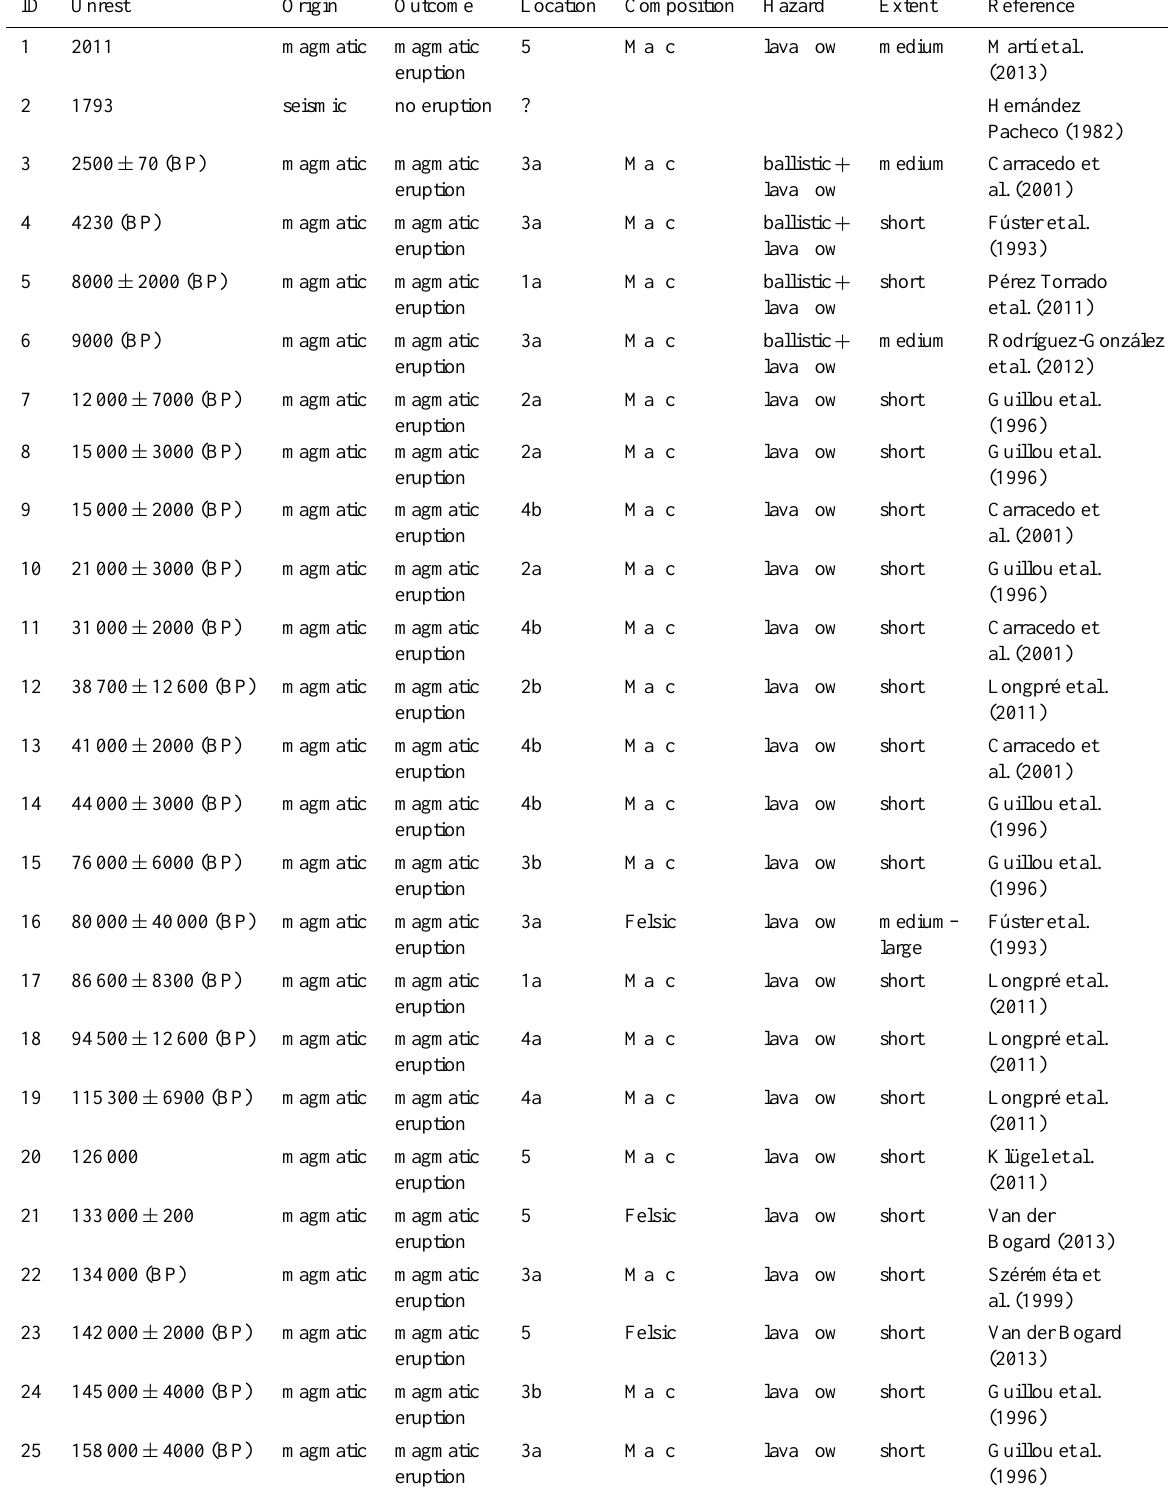
Table 1. The principal characteristics of the eruptions identified during the last constructive episode of El Hierro. The eruptions included in this table are those for which geochronological data exist and that are consistent with the field-relative stratigraphy established in this study. In addition to the geochronological data and the corresponding references, the rest of the information included in the table corresponds to information related to the first nodes in the HASSET (Sobradelo et al., 2014a) event tree used in this study. See text for more